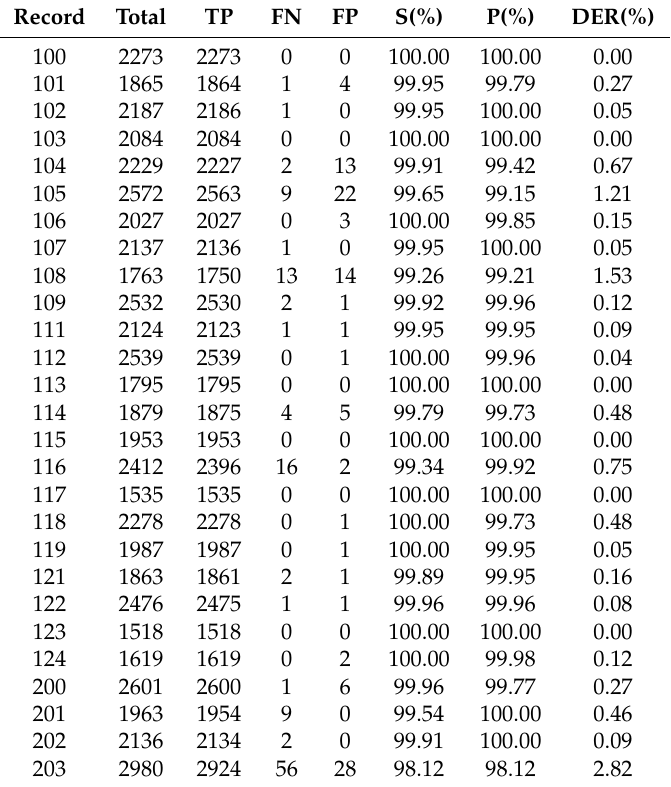
Table 4. Performance Evaluation of the proposed algorithm for the MIT-BIH Arrhythmia